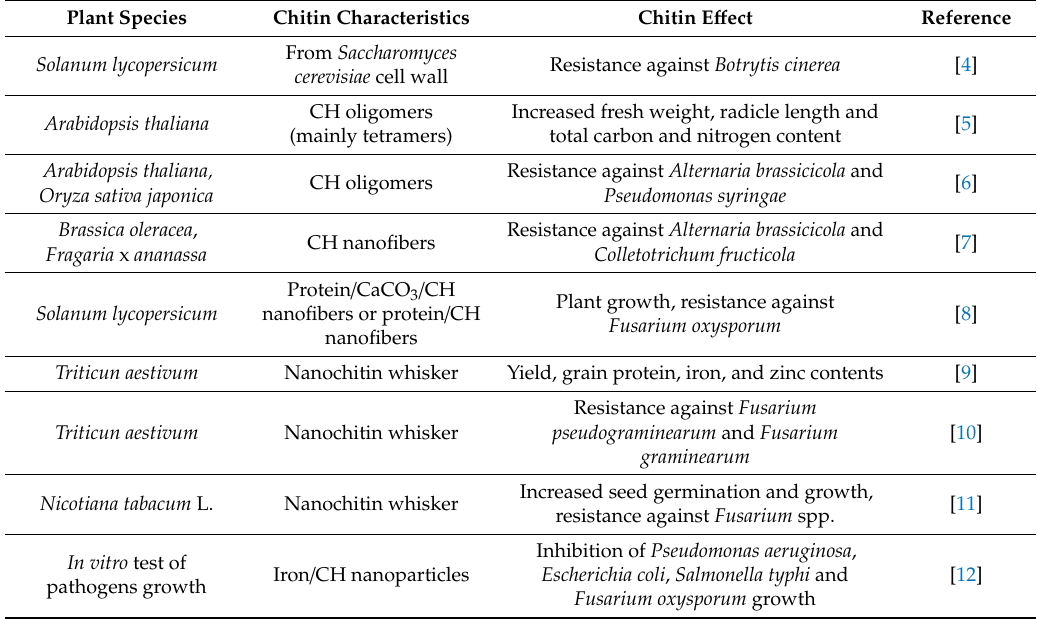
Table 1. Recent application of chitin-based